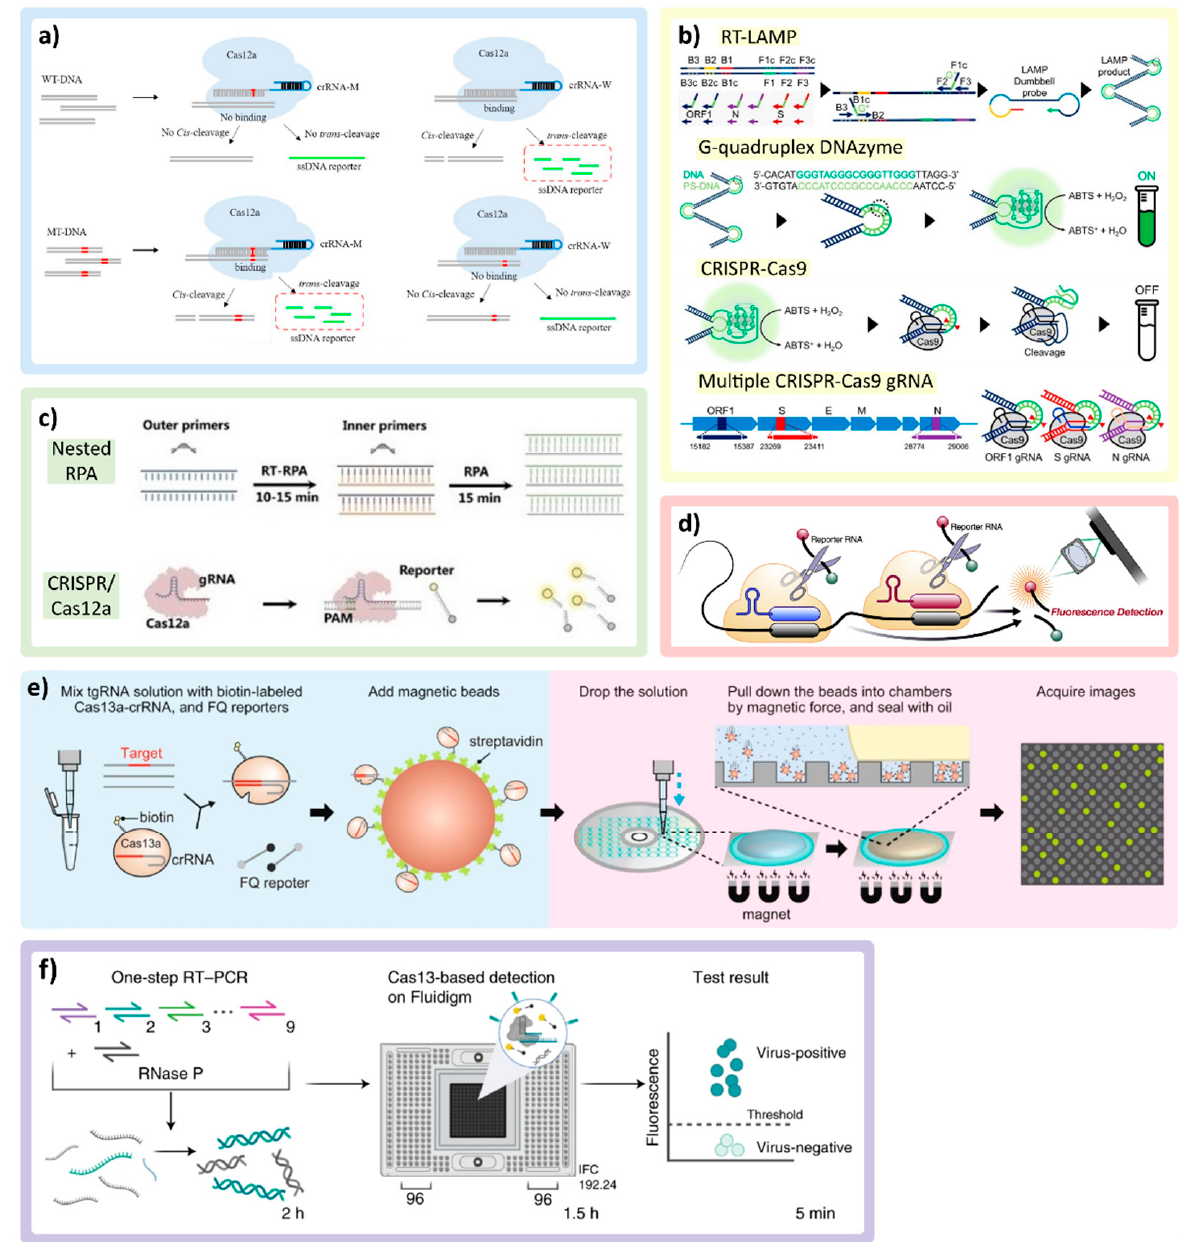
Figure 3. CRISPR/Cas technologies and multiplexing applications. ( a ) Demonstration of cis-cleavage and trans-cleavage of CRISPR/Cas mechanism, as crRNA-M recognizes the mutant DNA (MT-DNA). Adapted with permission from Ref. [70]. Copyright 2022, Elsevier. ( b ) Multiplex colorimetric assay triggered by LAMP (ON signal) and eliminating false positives by using a CRISPR/Cas9 system (OFF signal) to detect VOCs. Adapted with permission from Ref. [77]. Copyright 2022, American Chemical Society. ( c ) The combination of nested RPA and CRISPR/Cas12a in the same reaction pot. Adapted with permission from Ref. [75]. Copyright 2022, Wiley-VCH. ( d ) Multiple crRNAs targeting different regions of SARS-CoV-2 RNA with single reporter RNA type to improve the sensitivity of the assay. Adapted with permission from Ref. [12]. Copyright 2021, Elsevier. ( e ) The magnetic beads conjugated with CRISPR/Cas complex triggered by target RNA and pulled down by the magnetic force into the microchamber, concentrating the reactions. Adapted with permission from Ref. [74]. Copyright 2022, Springer Nature. ( f ) RT-PCR CRISPR-based diagnostic and microfluidic panel, mCARMEN, for parallelizing nucleic acid detection, utilizing a commercial chip Fluidigm, which can identify up to 21 viruses. Adapted with permission from Ref. [71]. Copyright 2022, Springer Nature.